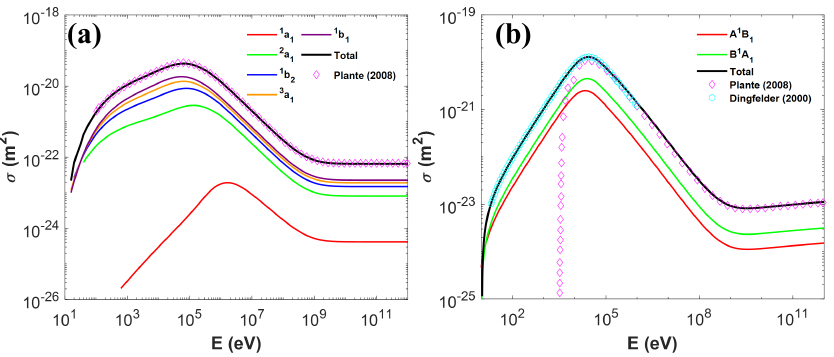
Figure 1. Total and partial cross-sections of ( a ) ionization and ( b ) excitation channels for protons with different energies.